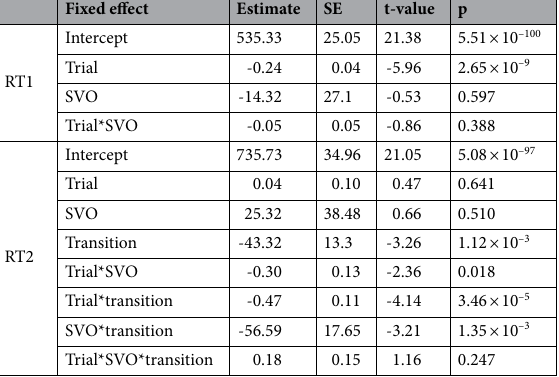
Table 1. Generalized linear mixed-effects models for the reaction times (RT1 and